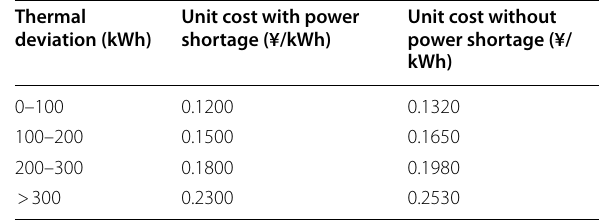
Table 5 Step price of demand side output at L N